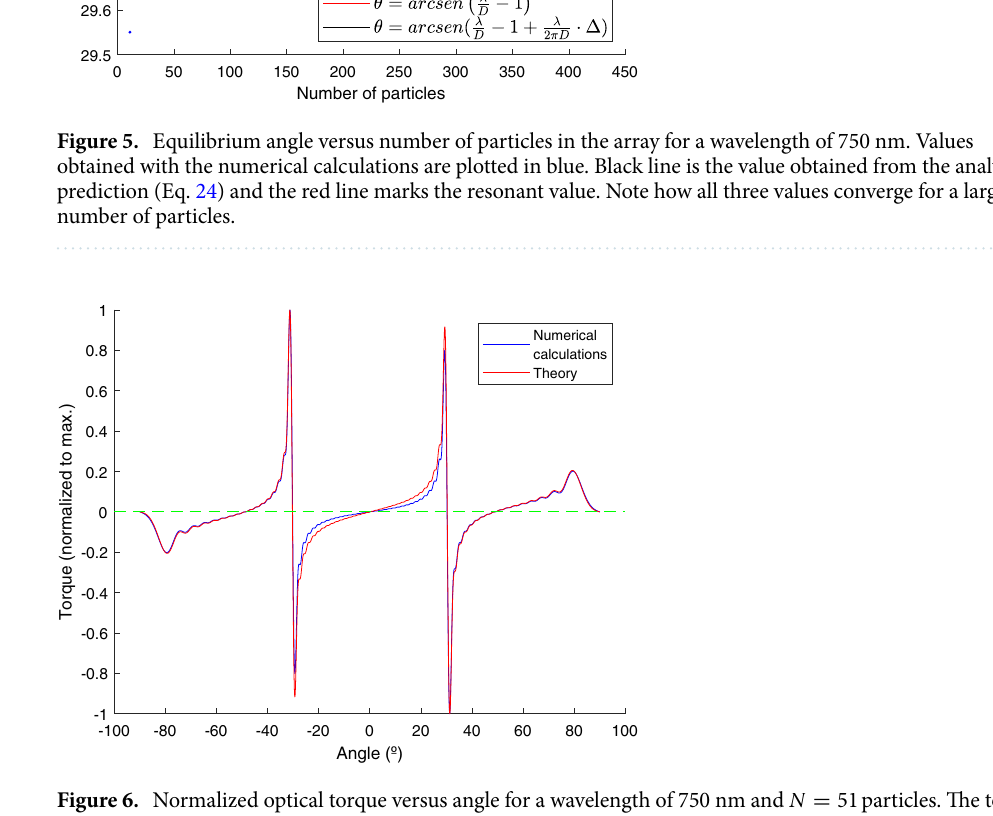
Figure 6. Normalized optical torque versus angle for a wavelength of 750 nm and N = 51 particles. The torque is obtained analytically (red line) using Eq. (15) and numerically (blue line) using CDA